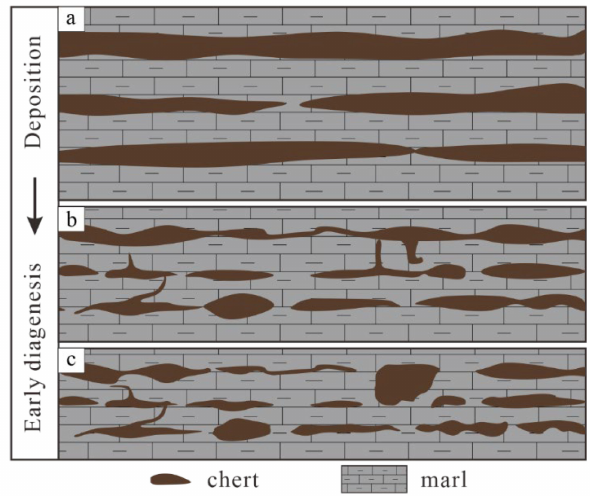
Figure 11. The formation model of chert nodules in the Lucaogou Formation from the Junggar Basin, NW China. ( a ) Siliceous sedimentation mainly displayed as banded or quasi-banded in depositional stage; ( b , c ) in early diagenesis, cherts deformed into nodular or lenticular